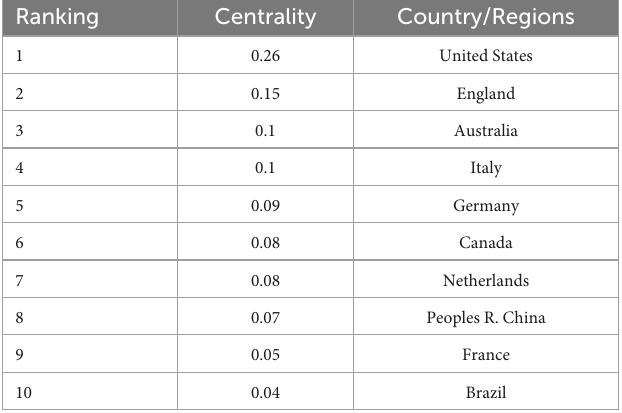
Ranking Centrality